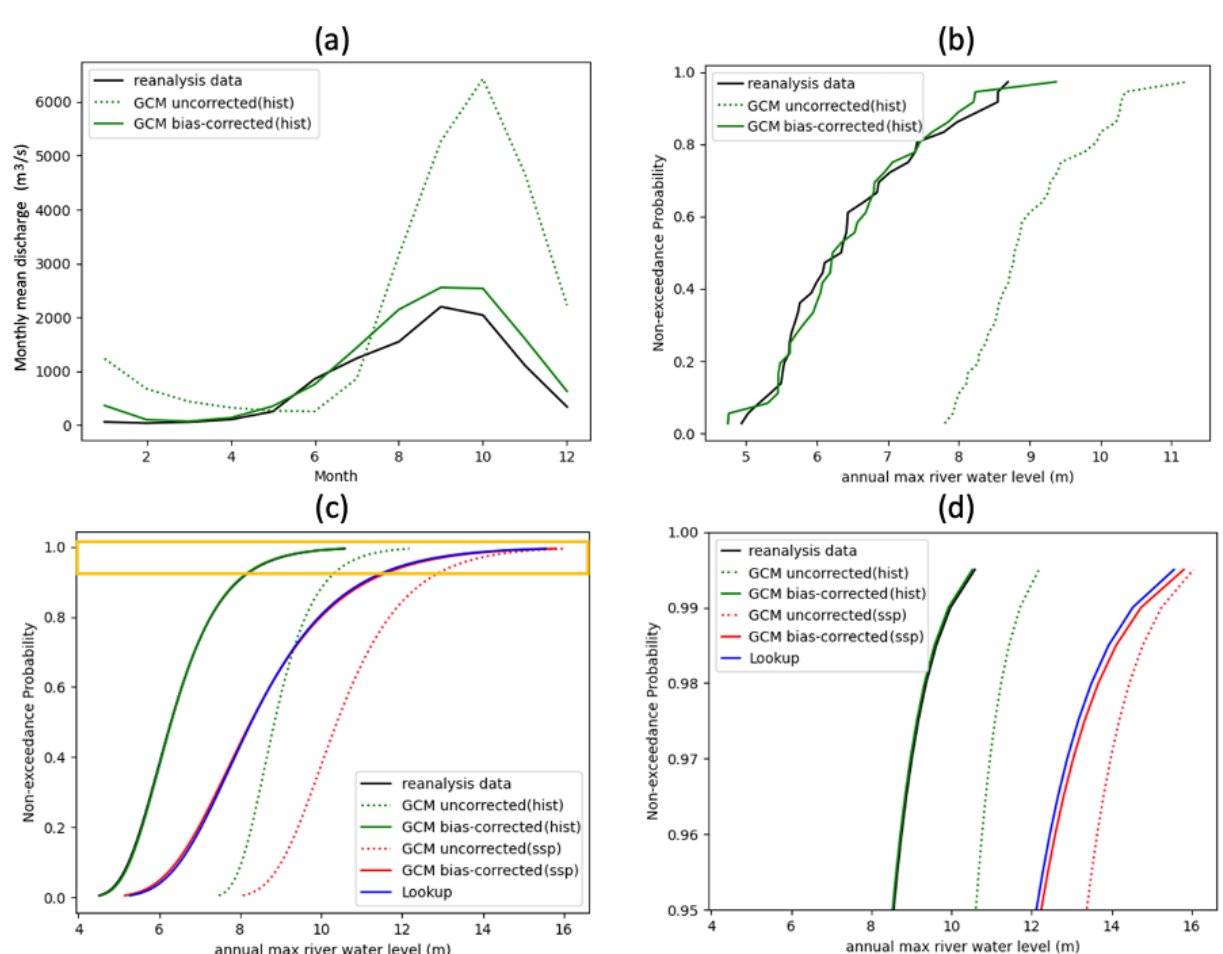
Figure 5. Comparison of reanalysis data, uncorrected GCM, bias-corrected GCM, and the lookup method at the GRDC Ubon station (104.8617 ◦ E, 15.2217 ◦ N). (a) Climatology of monthly mean discharge, (b) exceedance probability curve of the annual maximum river water levels from 1980 to 2014, (c) Gumbel distribution of annual maximum river water levels, and (d) enlarged view of the orange square in panel (c)